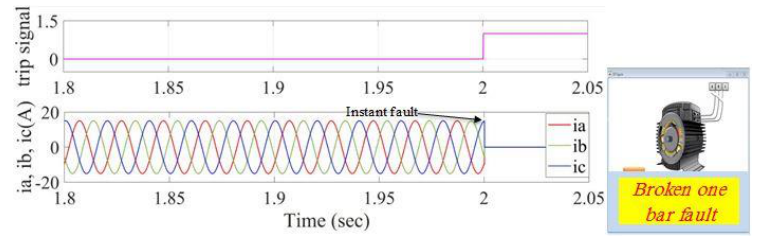
Figure 22. Stator current and trip signals of a broken one bar fault (application of the proposed method when it uses its moving window frame algorithm).